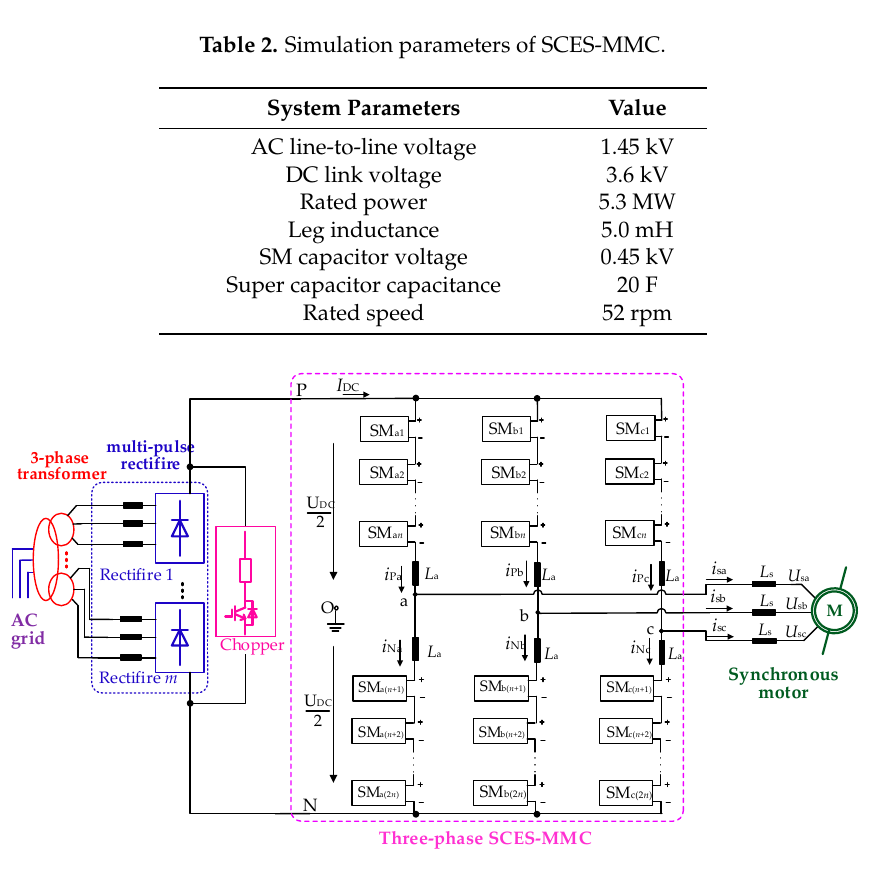
Figure 7. Configuration of SCES-MMC simulation model.